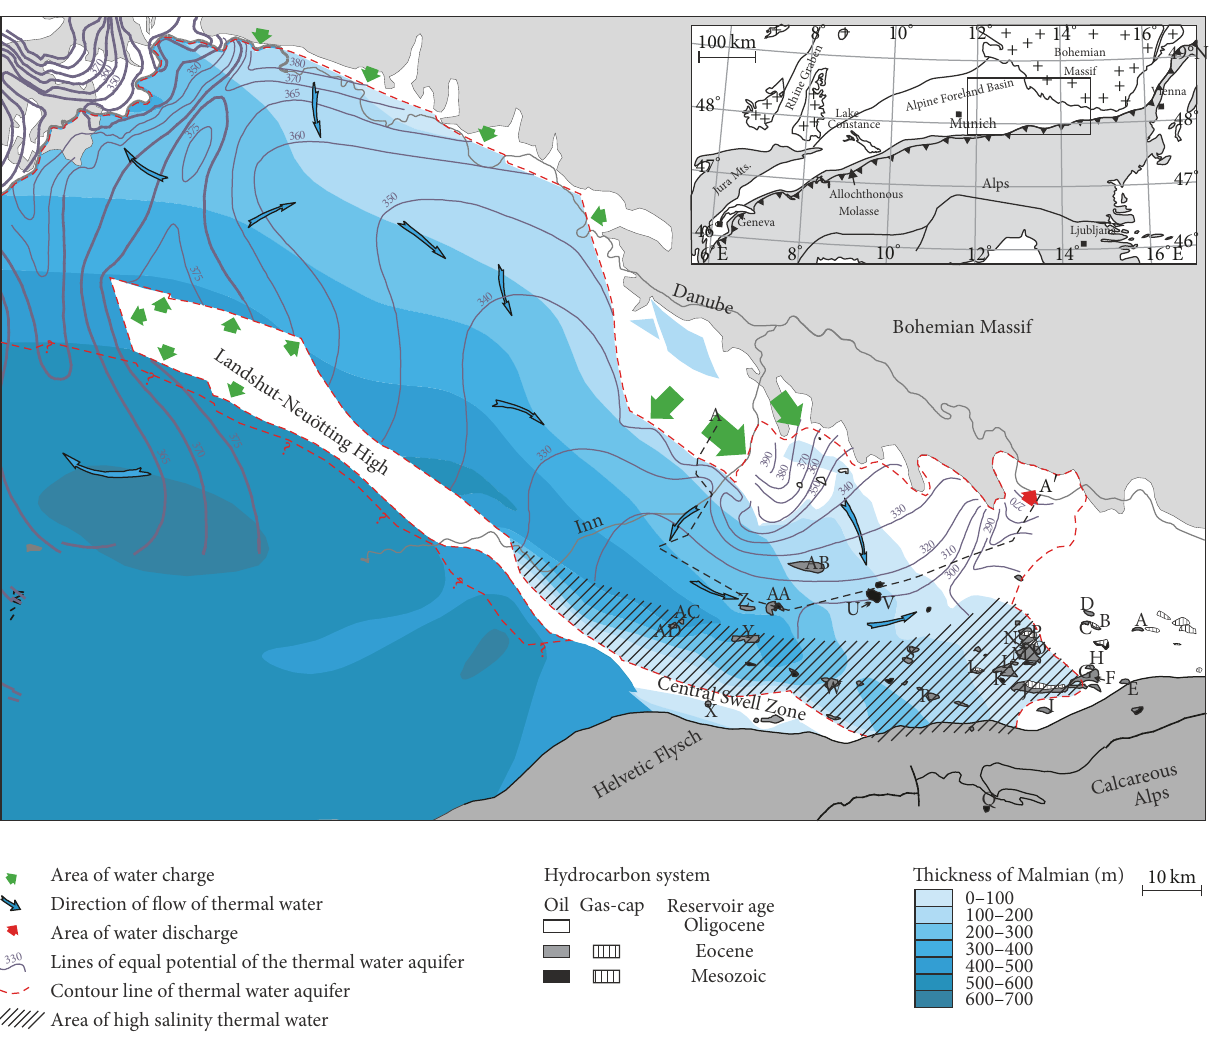
Figure 3: Thickness map of the Malmian horizon. Simplified thermal water system, regional water flow (modified from [8]), and location of oil fields are indicated. Inset presents location of map. Faults have been omitted to clarify the look of the map. The A-A 󸀠 cross section is presented in Figure